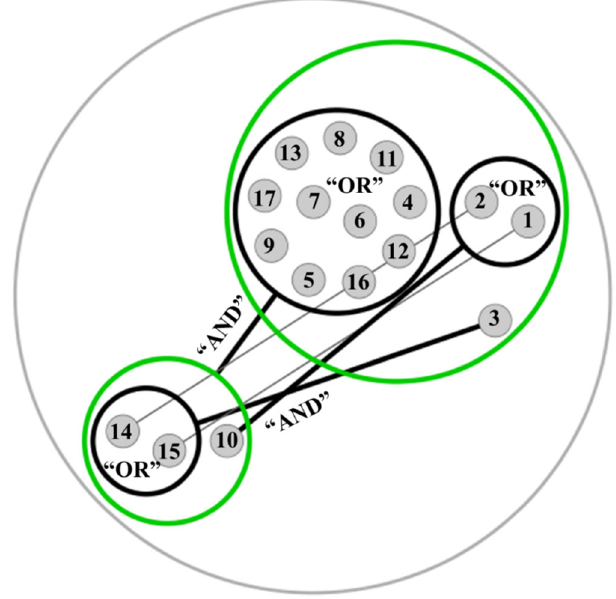
Figure 5. Metabolic network illustrating potential cross-feeding mechanisms between metagenome- assembled genomes (MAGs) recovered from the microbiota of healthy individuals in the presence of pectin. These MAGs involve beneficial arabinoxylan and pectin degraders ( Akkermansia muciniphila , Barnesiella viscericola DSM 18177, Paraprevotella xylaniphila YIT 11841) that were also found in the micro- biota of patients with Crohn’s disease (see Figure 1). In addition, MAGs of other microorganisms that were not identified in the microbiota of patients with Crohn’s disease and might be greatly affected by gut dysbiosis were also chosen. Network nodes (i.e., circles containing different microbial commu- nities showing equivalent metabolic functions) are connected by black lines indicating synergistic relationships between communities and complementary metabolic functions. Metabolic functions of MAGs from different nodes are needed to achieve the maximum number of end products from pectin as well as other colonic metabolites (this mutualistic relationship is indicated by the conjunction “AND”). MAGs inside the same node play the same role and could be replaced by other members from the same community (this similar role is indicated by the conjunction “OR”). ( 1 ): A. muciniphila